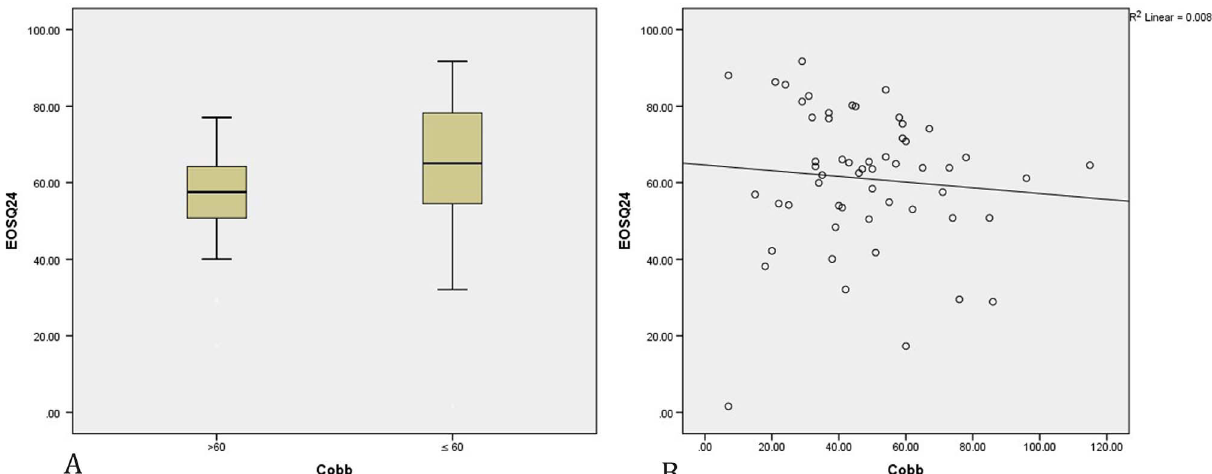
Figure 1. (A) Comparison of total scores between EOS patients with Cobb angle (cid:3) 60 (cid:3) and >60 (cid:3) were performed using Mann – Whitney U test. (B) Correlation between total scores and Cobb angles were evaluated using a Spearman rank correlation coef fi cient